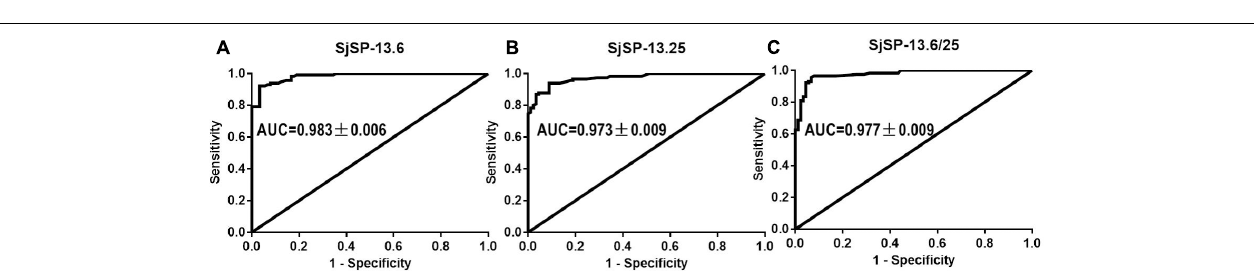
FIGURE 4 | SjSP-13.6 and SjSP-13.25 specific antibody levels in schistosomiasis patients and infected animals. (A) SjSP-13.6 and SjSP-13.25 specific antibody levels in schistosomiasis patients ( N = 115) and healthy controls ( N = 90). (B) SjSP-13.6 and SjSP-13.25 specific antibody levels in S. japonicum infected mice ( N = 10) and uninfected mice ( N = 10). (C) SjSP-13.6 and SjSP-13.25 specific antibody levels in S. japonicum infected rabbits ( N = 6) and uninfected rabbits ( N = 6).